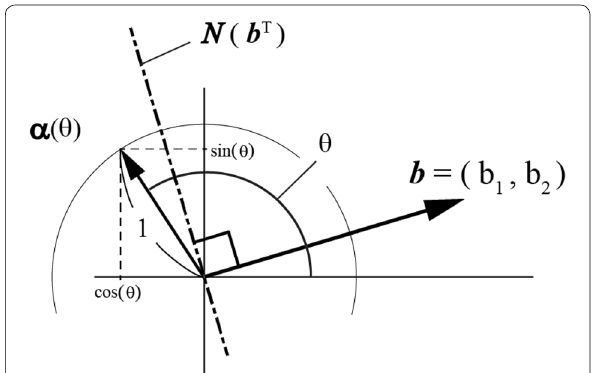
Fig. 3 Test signal allocator α which rotates by adaptive parameter θ , and coefficient vector b of the two-input redundant